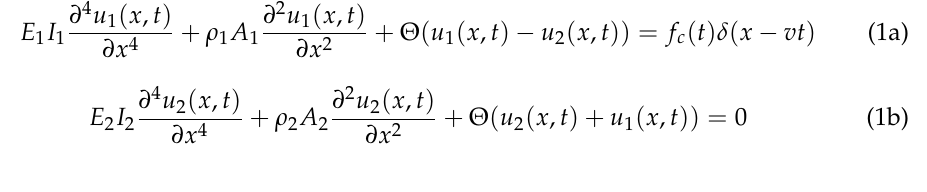
Figure 1. Sprung mass moving on a dual beam that represents the rail-track-bridge